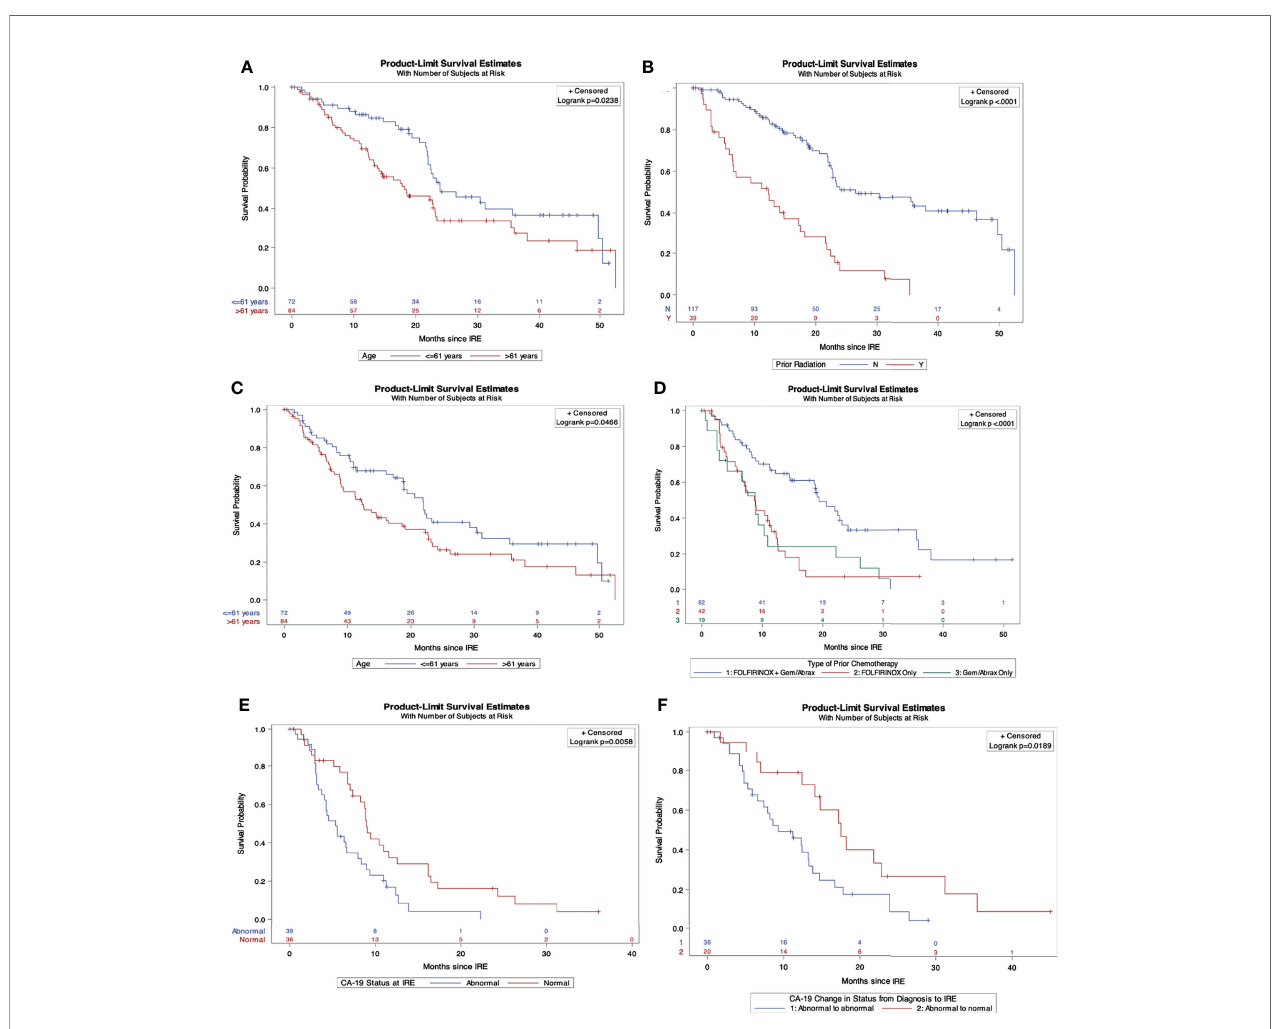
FIGURE 2 | Independent predictors of overall and progression free survival from IRE. (A) Overall survival comparison by age. (B) Overall survival comparison by prior radiation history. (C) Progression free survival comparison by age. (D) Progression free survival comparison strati fi ed by induction chemotherapy. (E) Overall survival comparison by CA19-9 status at IRE. (F) Progression free survival comparison of CA19-9 status from diagnosis to